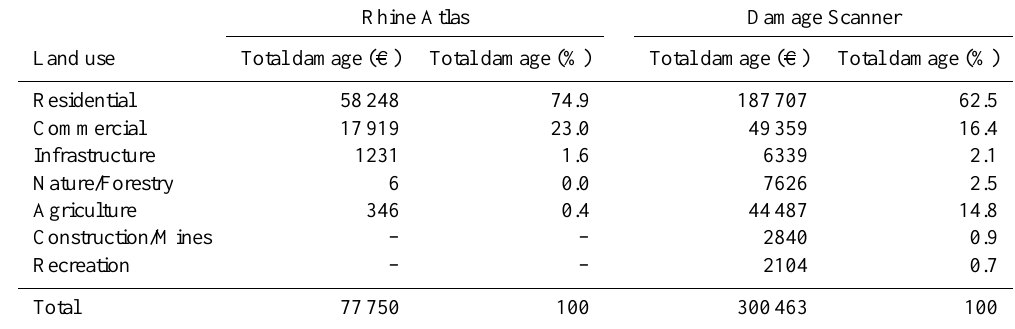
Table 5. Relative share of respective land-use types to total damage (2000) for the Rhine Atlas and the Damage Scanner models. Rhine